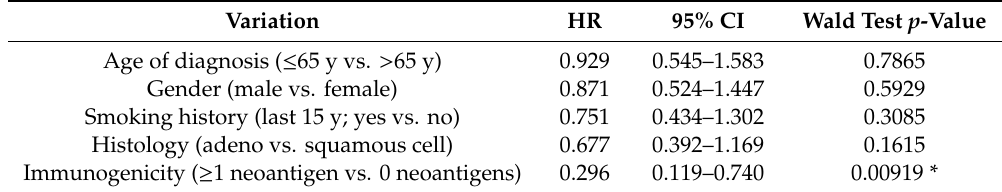
Figure 3. TCGA NSCLC patients stratified by immunogenic neoantigens. ( A ) Stage I patients (47 with neoantigens, 171 without neoantigens) are grouped into those with immunogenic neoantigens and those with none. Hazard ratios and log-rank p -values compare immunogenic patient tumors to non-immunogenic patient tumors. ( B ) The overall survival differences of stage I patients were classified based on the presence of immunogenic neoantigens and the number of altered genes. Immunogenic and high-NAG patient tumors (green, 37 patients) vs. non-immunogenic and low-NAG patient tumors (red, 23 patients) show HR = 0.0807, p = 7.8 × 10 − 5 . Immunogenic and high-NAG tumors (green) vs. non-immunogenic and high-NAG patient tumors (blue, 147 patients) show HR = 0.229, p = 0.013. Non-immunogenic and high-NAG tumors (blue) vs. non-immunogenic and low-NAG patient tumors (red) show HR = 0.309, p = 7.9 × 10 − 5 . High NAG patients with and without neoantigens were contrasted based on the relative abundance of immune cell types estimated by the TIMER algorithm ( C ), and the RNA expression of cytotoxic T-cell markers ( D ). Significant differences for each component are marked ( t -test p -value * <0.05; ** <0.01). Table 2. Multivariate survival model of the immunogenicity factor with clinical-pathological factors of TCGA NSCLC stage I